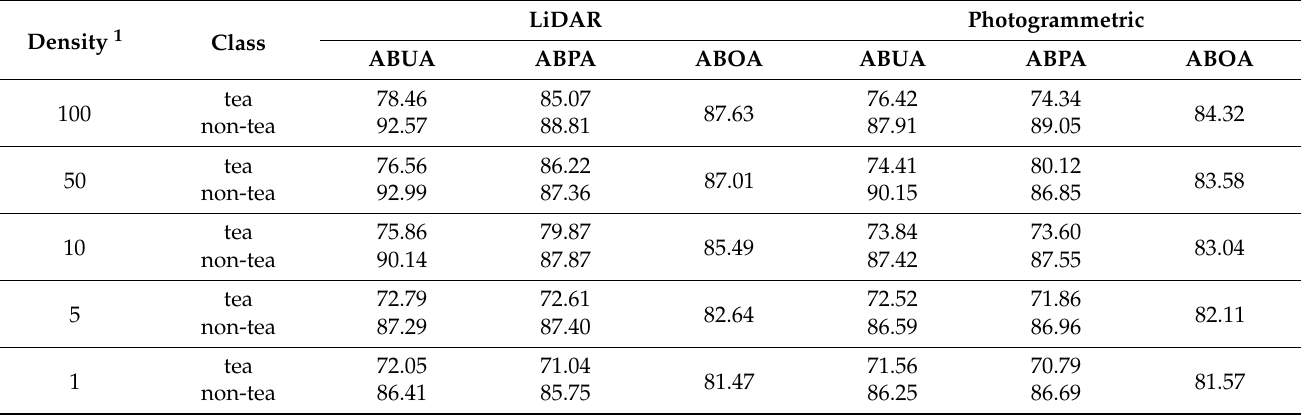
Table 9. Summary of the area-based descriptive statistics as percentages (%) using the RF algorithm. ABUA: area-based user’s accuracy; ABPA: area-based producer’s accuracy; ABOA: area-based